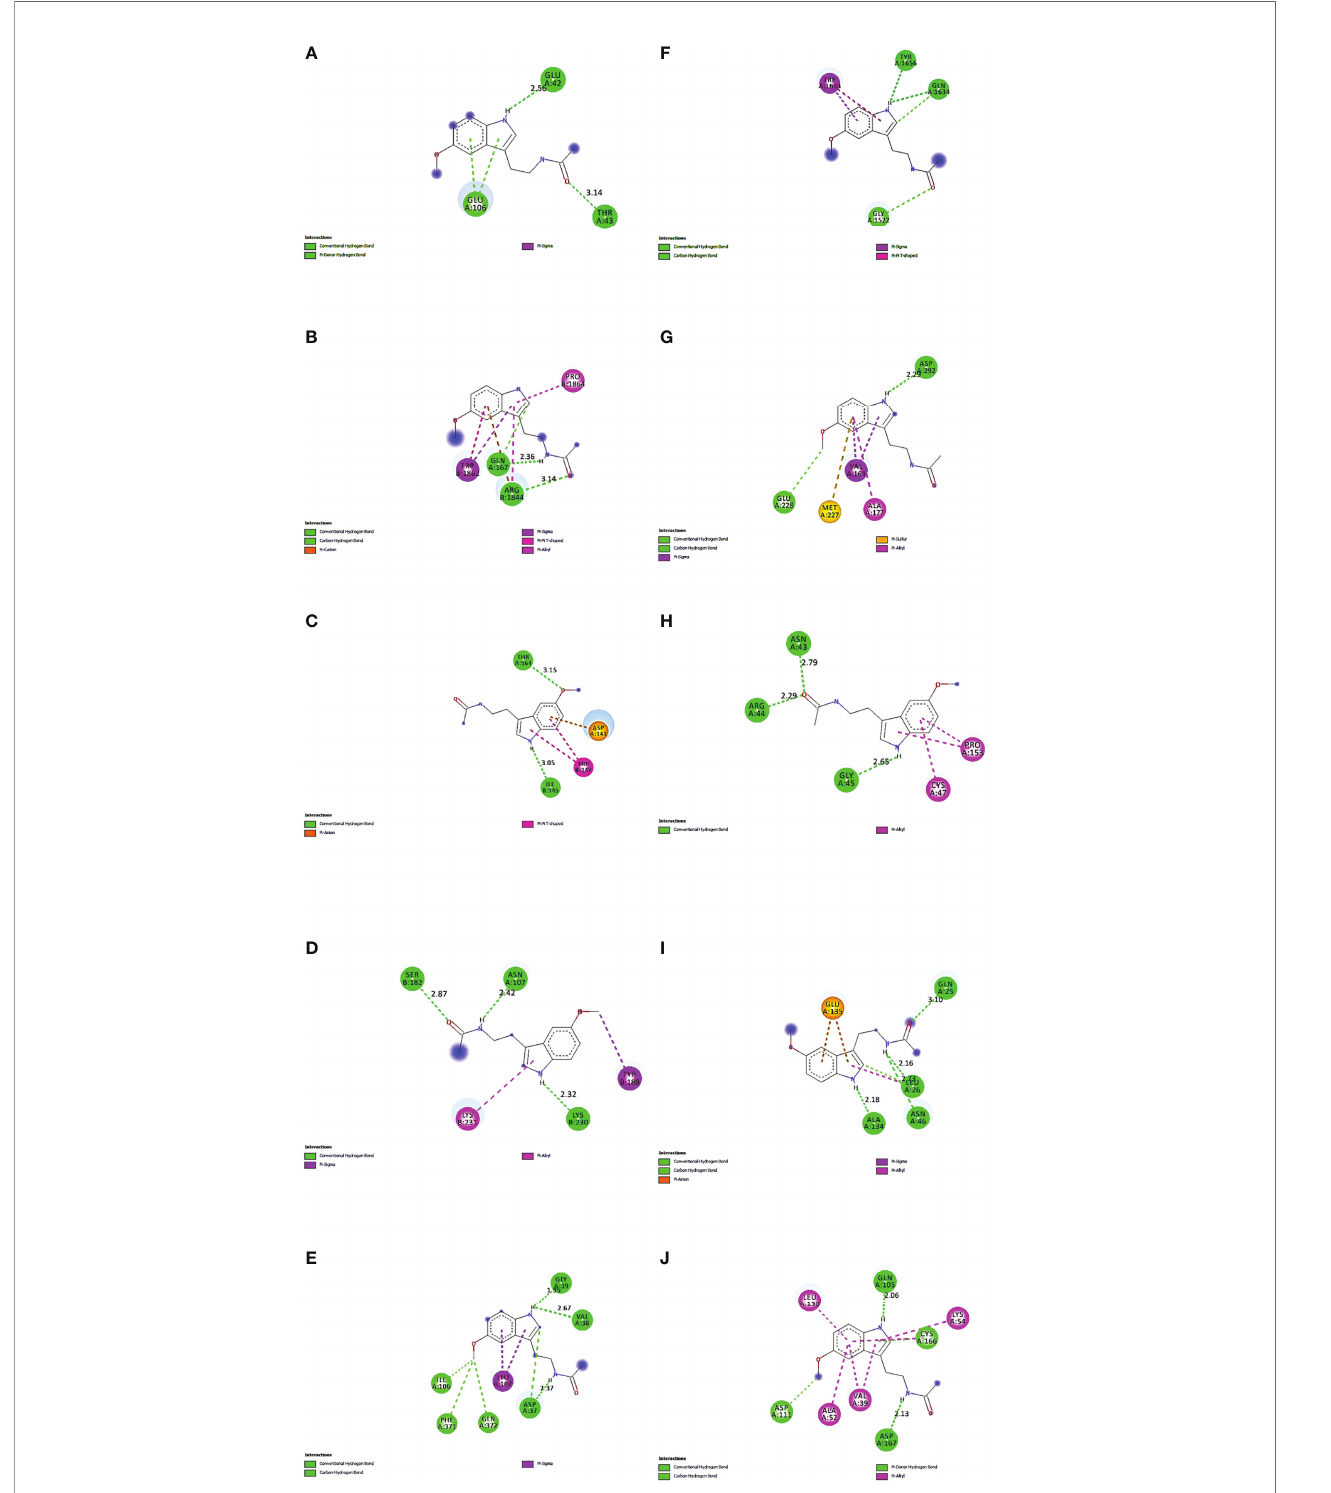
FIGURE 9 | Molecular Docking results of melatonin with top 10 target proteins. (A) Binding of melatonin with IL-6. (B) Binding of melatonin with TP53. (C) Binding of melatonin with ERBB2. (D) Binding of melatonin with IL1B. (E) Binding of melatonin with MAPK3. (F) Binding of melatonin with MTOR. (G) Binding of melatonin with AKT1. (H) Binding of melatonin with PTGS2. (I) Binding of melatonin with TNF. (J) Binding of melatonin with